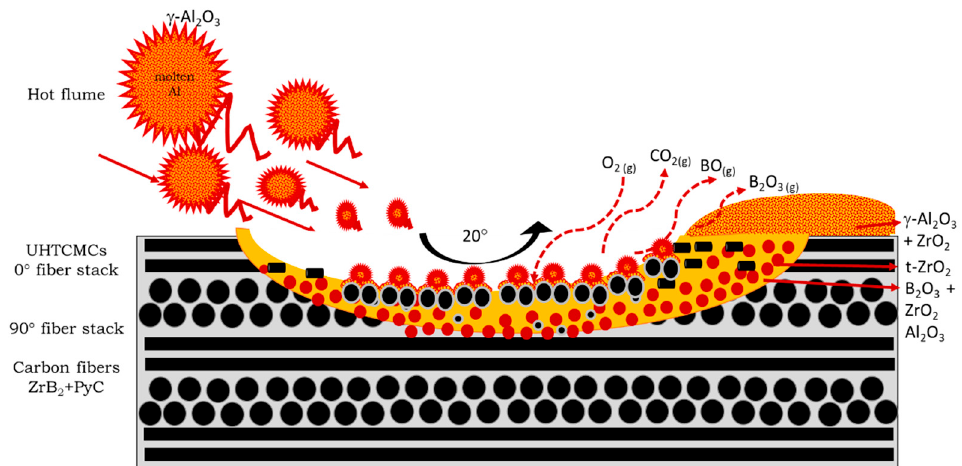
Figure 15. Schematic highlighting the ablation of UHTCMCs with solid propellants.